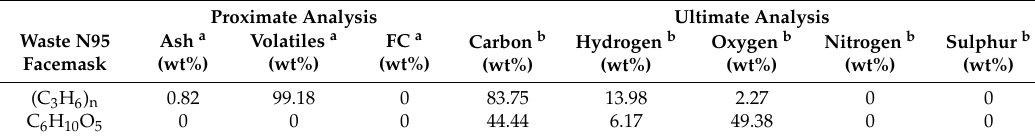
Table 1. Composition of representative waste N95 facemask (75 wt% of polypropylene) employed in the present study